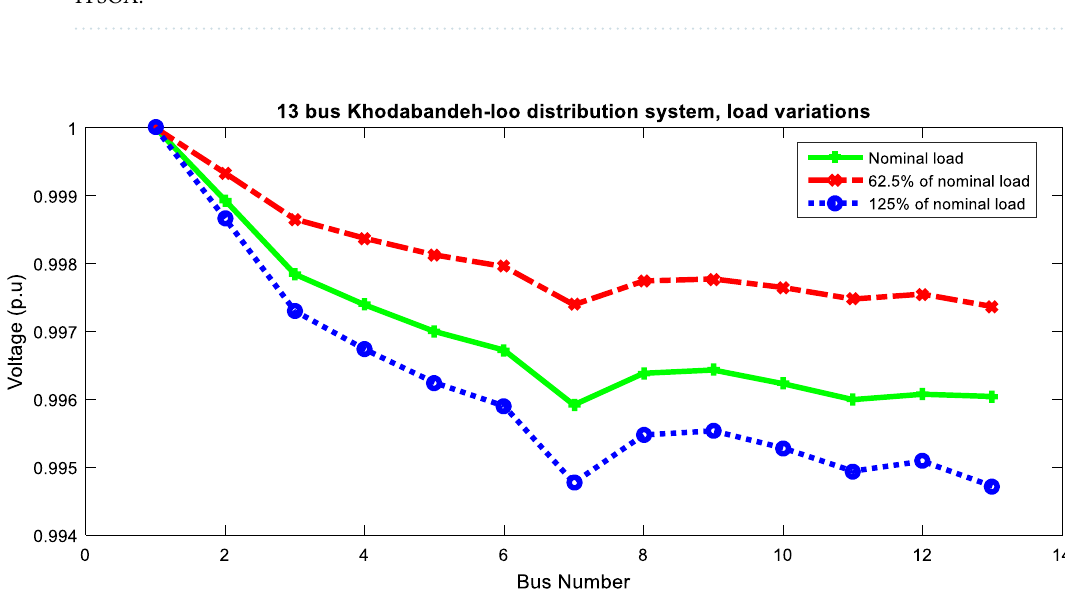
Figure 8. Voltage profile of unbalanced 13-bus network in different loading using ITSOA after reconfiguration.